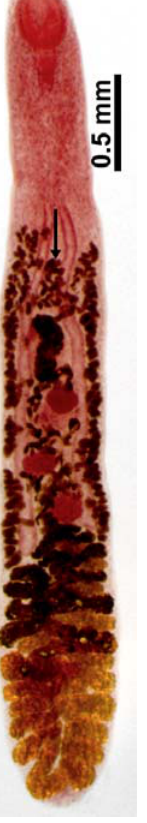
Figure 1. Haplometroides intercaecalis (Digenea, Plagiorchiidae) from the esophagus of Phalotris matogrossensis (Serpentes, Colubridae). Note the intercecal distribution of the vitellaria in the preacetabular region